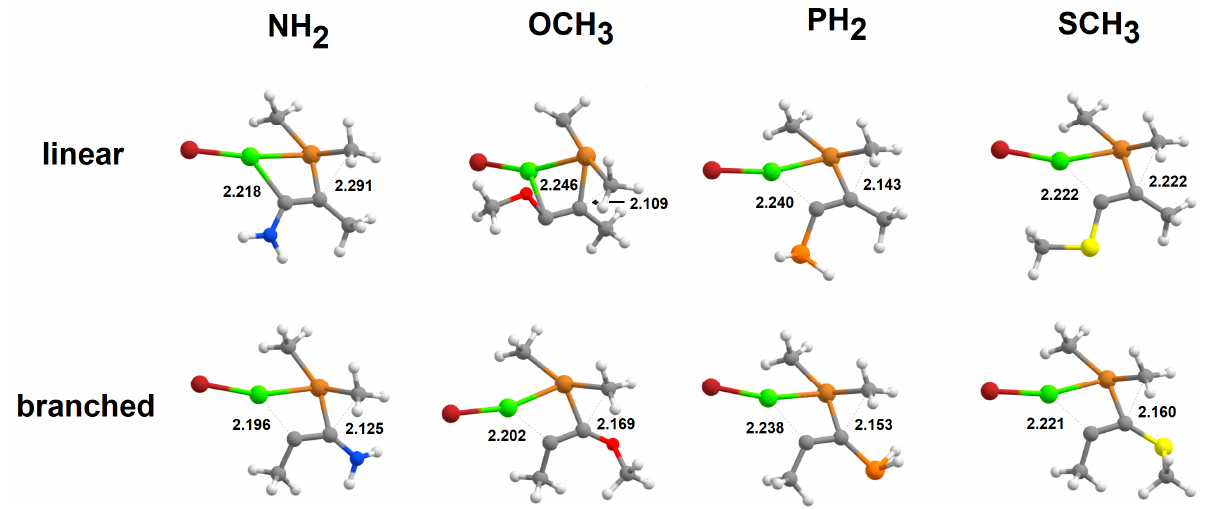
Figure 7. Transition state geometries for the methyl transfer from Cu(CH 3 ) 2 ·MgBr to alkynes of the form R-C ≡ C-CH 3 .